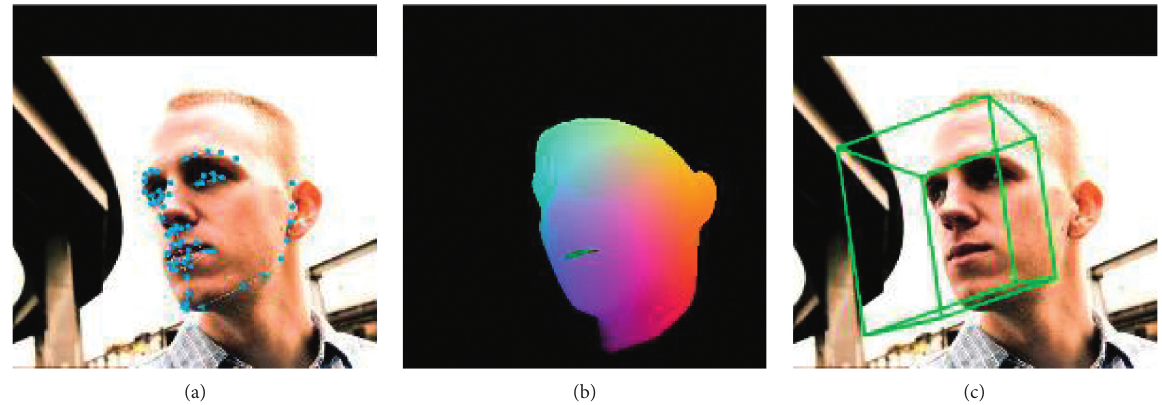
Figure 8: [30 ° , 60 ° ], medium-pose face alignment